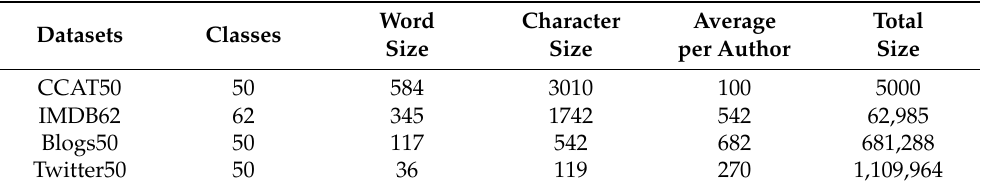
Table 2. Description of the experimental